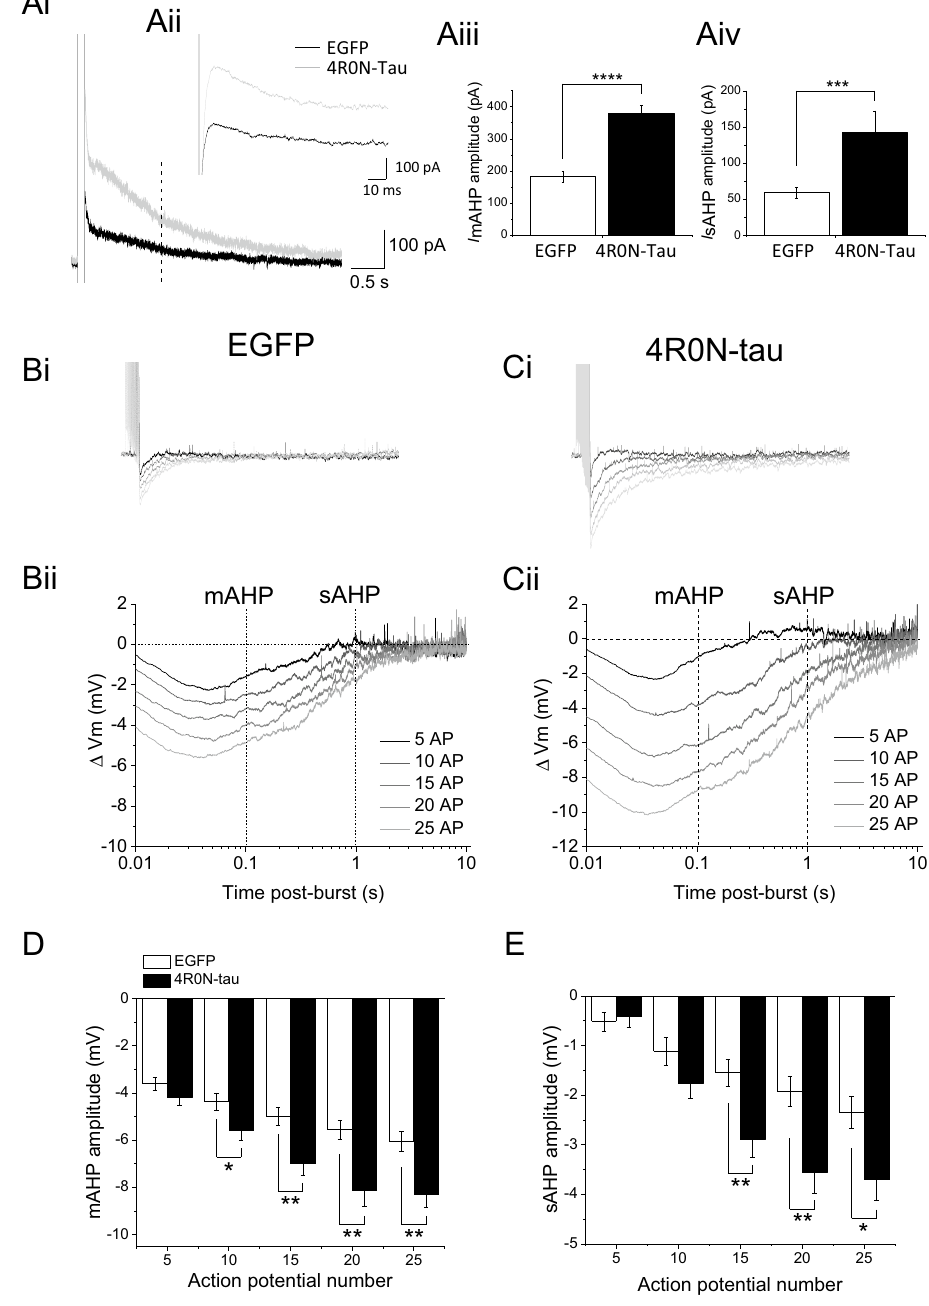
Figure 1. Expression of 4R0N-tau augments the afterhyperpolarization in hippocampal CA1 pyramidal neurons. ( Ai ) Membrane current evoked by a step depolarization to + 10 mV (100 ms duration) and measured at the holding potential of − 50 mV. Current represents that underlying the medium and slow AHPs, with the current underlying the medium AHP shown at higher resolution in ( Aii ). Expression of 4R0N-tau produced a larger amplitude of current underlying both components of AHP (gray trace), when compared with current evoked in cells expressing only EGFP (black trace). ( Aiii ) Bar chart showing augmentation of the current underlying the medium AHP by expression of 4R0N-tau (mean ± s.e.m) ( p < 0.0001). ( Aiv ) Expression of 4R0N-tau significantly augmented the amplitude of the current underlying the slow AHP ( p = 0.00097) (EGFP n = 53, 4R0N-tau n = 33). ( Bi,Ci ) Membrane voltage traces showing AHP amplitude increases with action potential (AP) number (5–25 action potentials) in both EGFP-expressing ( Bi ) and 4R0N-tau-expressing ( Ci ) CA1 pyramidal neurons. ( Bii , Cii ) Voltage traces from ( Bi , Ci ) plotted on a log 10 time scale for greater clarity of the medium AHP and slow AHP profiles for a cell expressing EGFP alone ( Bii ) and for a cell expressing 4R0N-tau ( Cii ). The medium AHP is measured 100 ms after the last action potential, while the slow AHP was measured 1 s after the last AP. The increase in the medium ( D ) and slow ( E ) AHP components with increasing AP number is augmented in cells expressing 4R0N-tau, when compared with cells expressing EGFP alone. Two-way RM ANOVA with post-hoc LSD t -test. EGFP n = 58; 4R0N-tau n = 36; * p ≤ 0.05, ** p ≤